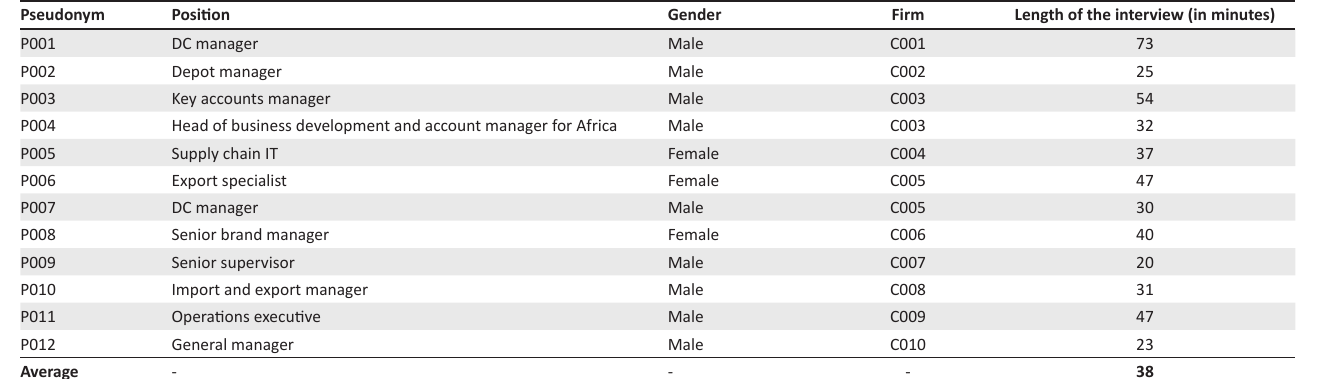
TABLE 1: Profile of the study